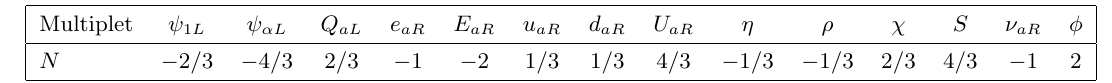
Table 1 . N -charge of the model’s multiplets.